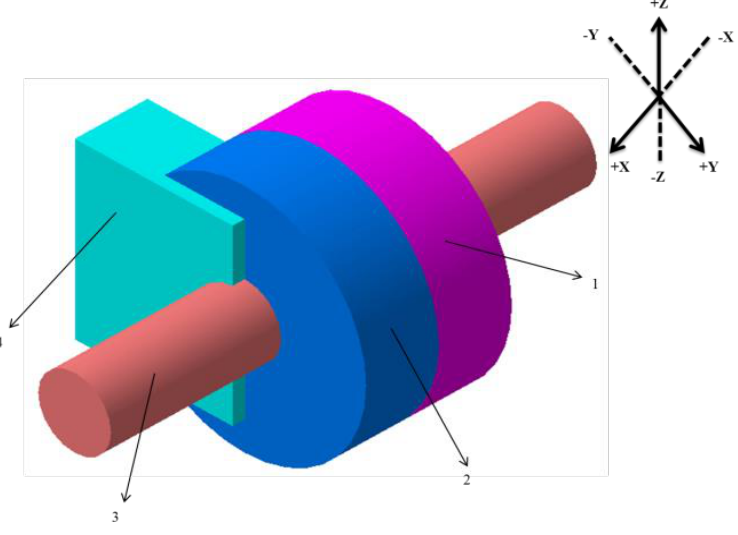
Figure 2. Represents the block assembly for the clash analysis